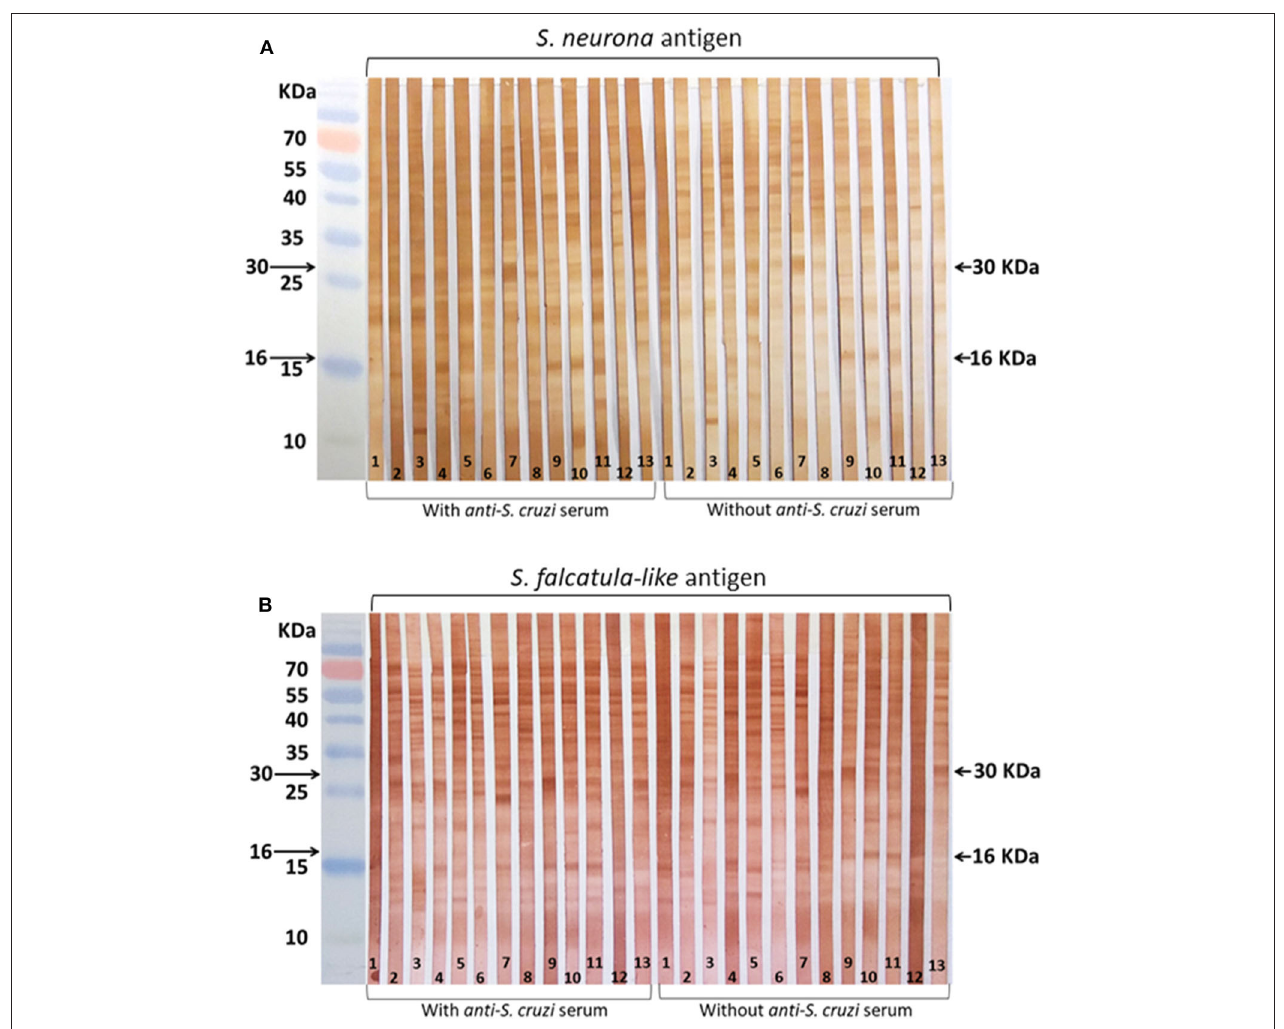
FIGURE 1 | Horse sera tested by Western blot (WB). Serum samples were selected for WB by immunofluorescence antibody tests (IFATs). (A) Membrane strips coated with Sarcocystis neurona antigen; (B) membrane strips coated with Sarcocystis falcatula– like antigen. Reactions were conducted with and without blocking treatment with bovine anti– Sarcocystis cruzi serum. Strip 1: negative control (horse serum from New Zealand); 2–3: sera that tested negative for both parasites by IFAT; 4–9: sera that tested positive for S. neurona by IFAT; 10–13: sera that tested positive for S. falcatula– like by